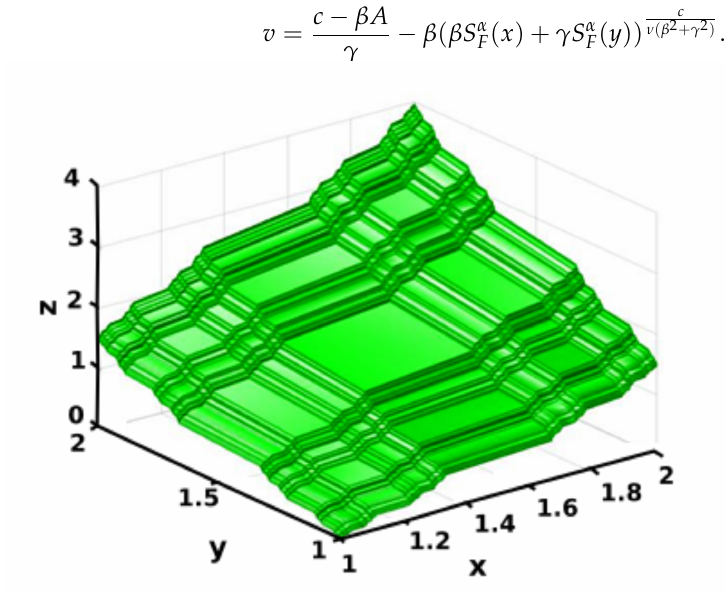
Figure 1. The u component (Equation (22)) is the fluid velocity in the fractal space for the function ( x ) + γ S α ( y ) for which α = 0.63, β = 1, γ = 1, A = 1, B = 1, c = 1. f = β S α F F